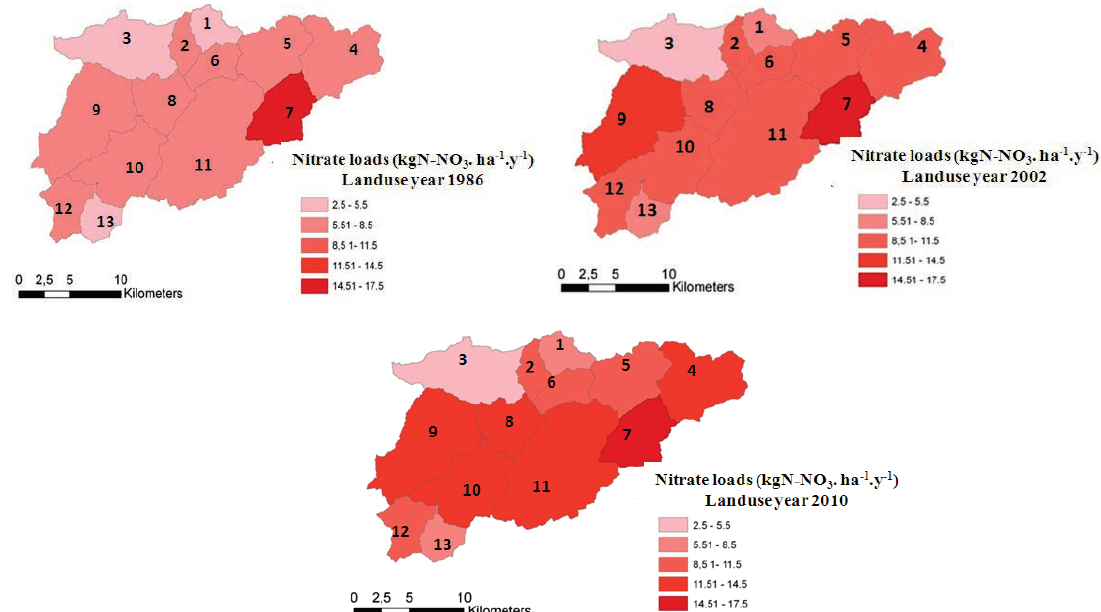
Fig. 6 Spatial distribution of nitrate fluxes across sub-basins of the Joumine